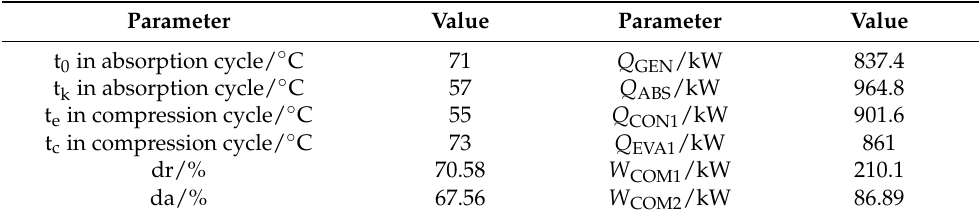
Table 3. Thermodynamic properties of some important state